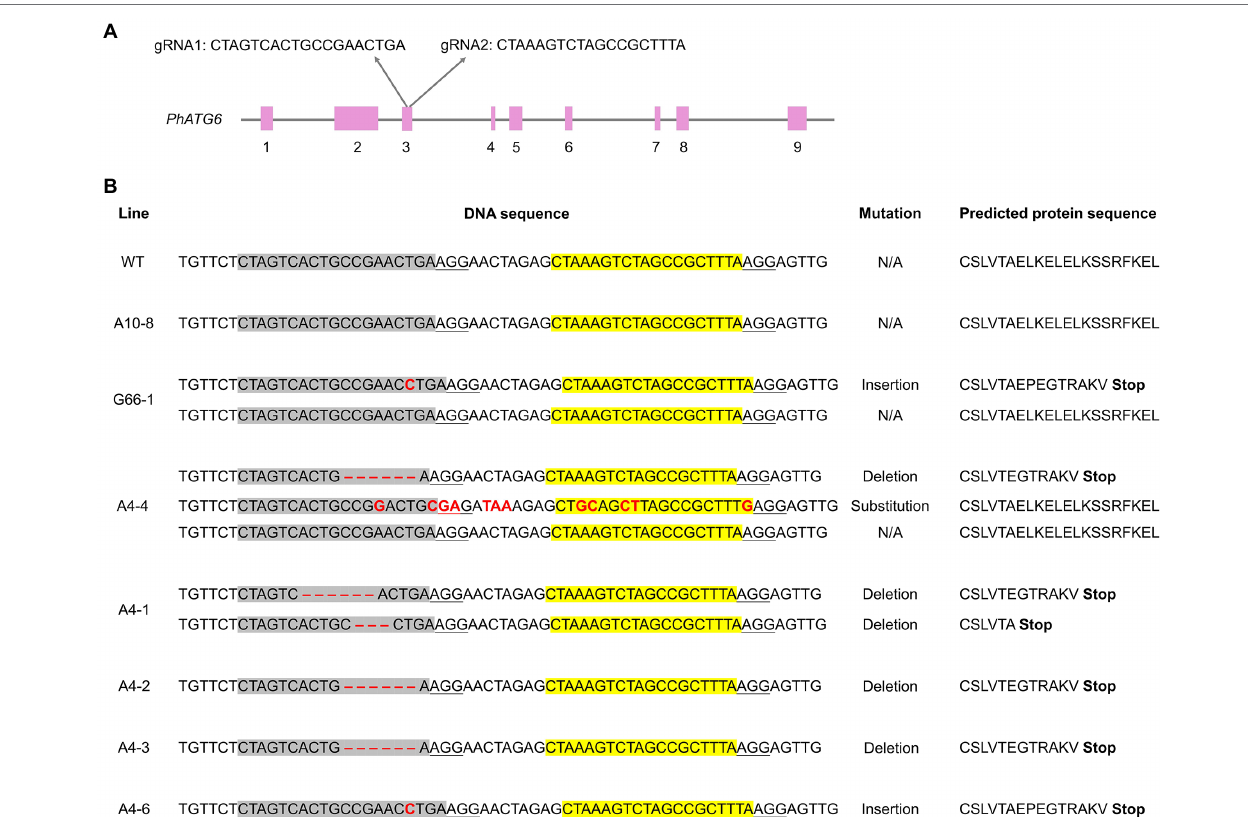
FIGURE 1 | CRISPR/Cas9-edited sequences of Autophagy Gene 6 ( PhATG6 ) in T 0 Petunia × hybrida ‘Mitchell Diploid’ plants with mutated PhATG6 and wild-type control (WT). (A) Two guide RNAs (gRNAs) were used to target PhATG6 exon 3. (B) DNA sequences and predicted protein sequences of PhATG6 exon 3 in wild- type plant, non-mutated regenerated line A10-8, and different PhATG6 -KO lines. Pink boxes represent exons 1–9 of PhATG6 , grey sequences represent the targeted site of gRNA1, yellow sequences represent the targeted site of gRNA2, and red texts represent mutation sites. The protospacer adjacent motif (PAM) for Cas9 recognition (NGG) was underlined. N/A represents no mutation